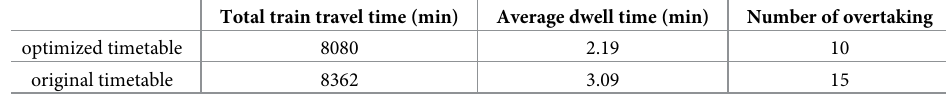
Table 11. Comparison of evaluation indexes for original and optimized timetables. Total train travel time (min) Average dwell time (min) Number of overtaking optimized timetable 8080 2.19